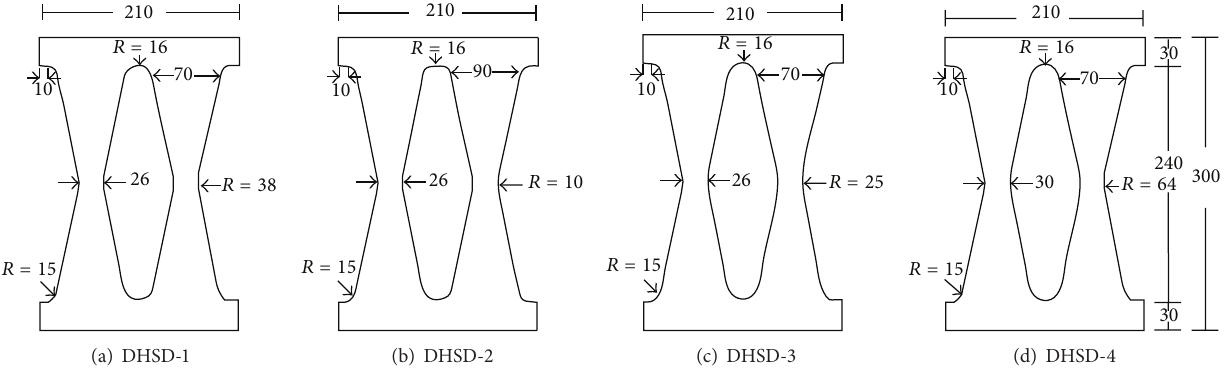
Figure 3: Details of test